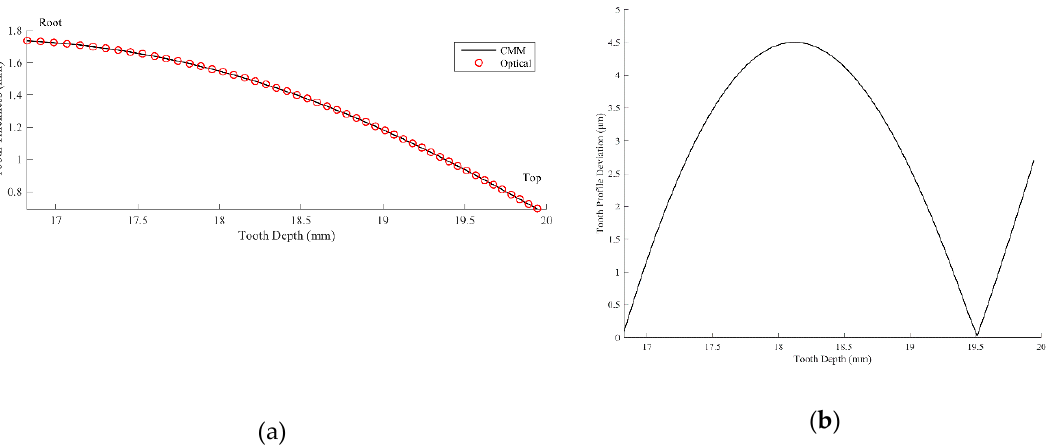
Figure 11. ( a ) Radial (involute) profiles measured by the CMM and optical system; ( b ) deviation of the involute profile of the projection moiré system from the CMM method.